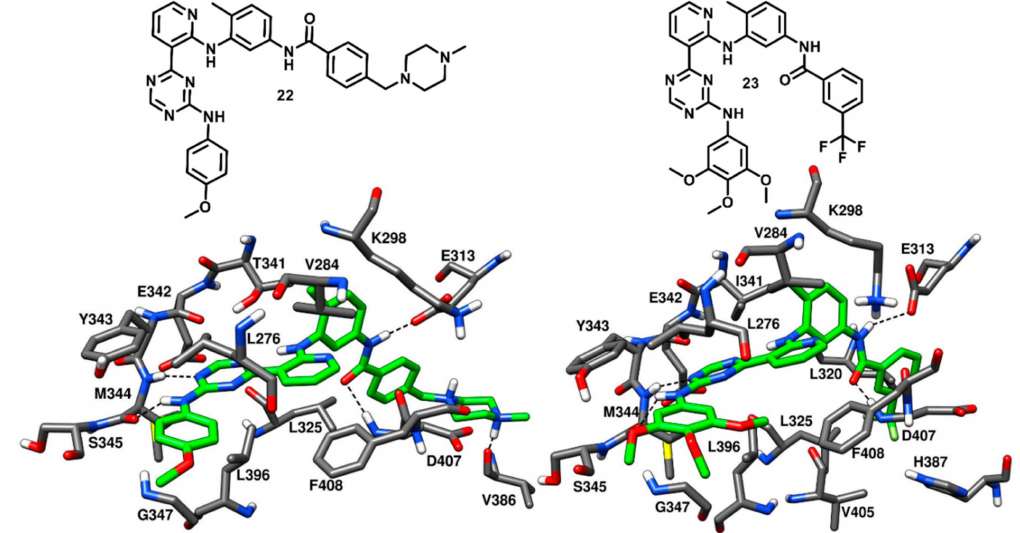
Figure 19. 2D structures of 22 and 23 . X-ray structures of c-Src kinase in complex with 22 (PDB ID: 3G6G) and T341I c-Src in complex with 23 (PDB ID: 3G6H). Active site residues of c-Src kinase and the enzyme–inhibitor H-bond interactions are